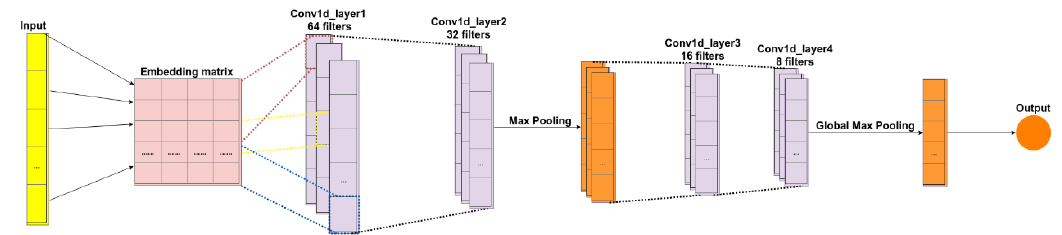
Figure 3. A convolutional neural network.